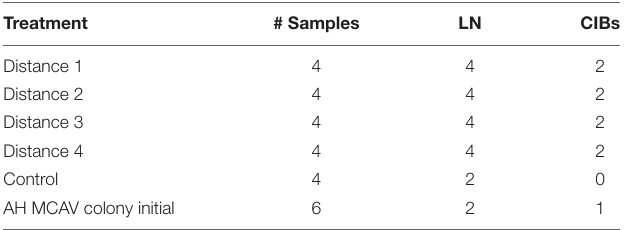
TABLE 3 | Histological samples examined for baseline lytic necrosis (LN) and crystalline inclusion bodies (CIBs) in M. cavernosa donors prior to the M. cavernosa to M. cavernosa disease induction experiment.